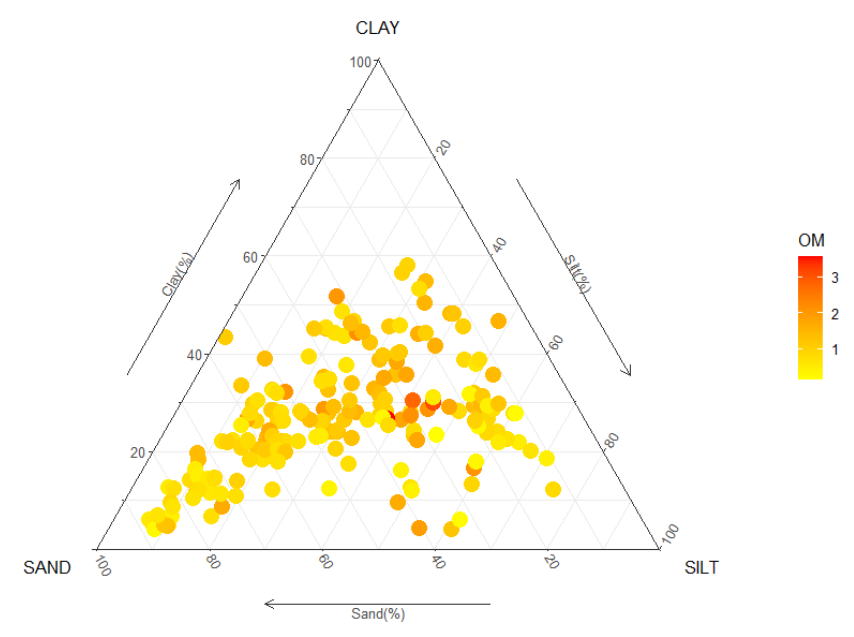
Fig. 3: Texture and OM of the studied soils. Table 4: Summary for the physicochemical parameters analyzed in agricultural soils of the study area Parameter Maximum Mínimum Mean SD